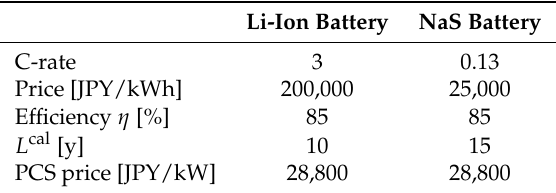
Table 4. Parameters of energy storage systems (ESSs).